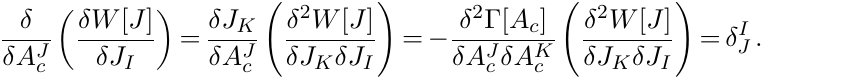
Figure 12 . Each dark blob in this figure represents the sum of connected diagrams, whereas the white blob on the right represents the third derivative of Γ[ A derivative of Γ[ A ] is just the connected correlation function with all three full propagators removed, c i.e. the one-particle-irreducible three-point